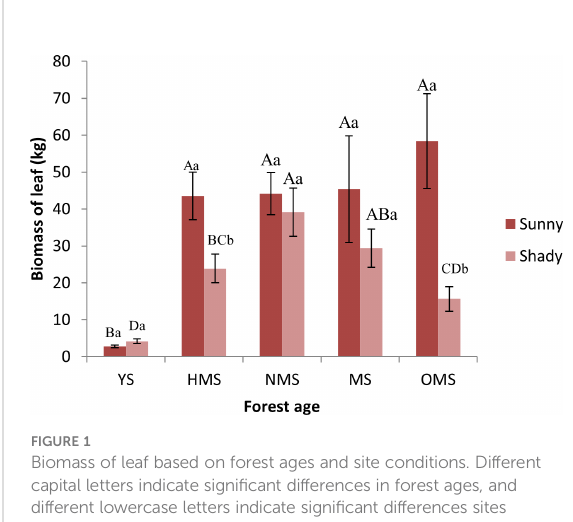
FIGURE 1 Biomass of leaf based on forest ages and site conditions. Different capital letters indicate signi fi cant differences in forest ages, and different lowercase letters indicate signi fi cant differences sites conditions ( p< 0.05). YS, Young stage; HMS, Half-mature stage; NMS; Near-mature stage; MS, Mature stage; OMS, Over-mature stage; Sunny, Sunny slope; Shady, Shady